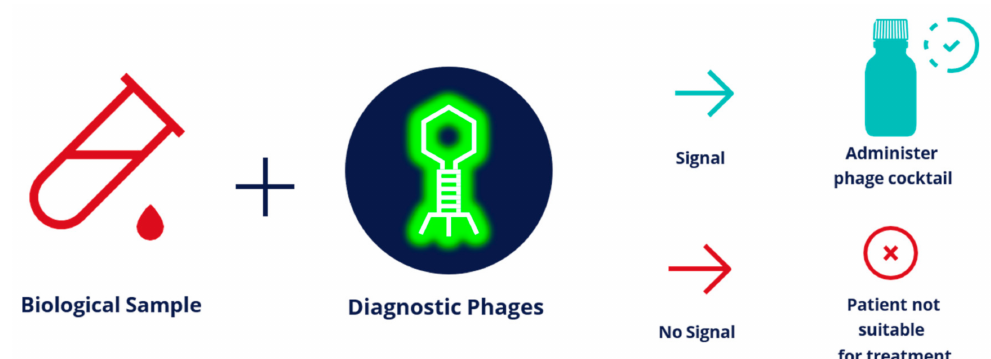
Figure 1. A schematic model of phage-based diagnostics. The biological sample is incubated with the luminescent phage cocktail; the detection of a luminescent signal validates the presence of the target bacteria in the sample. This ensures that the administration of the cocktail will result in phage activity within the patient. If no luminescence signal is detected, the target bacteria are not present in the sample (and therefore in the patient), hence the cocktail is considered not to be suitable for